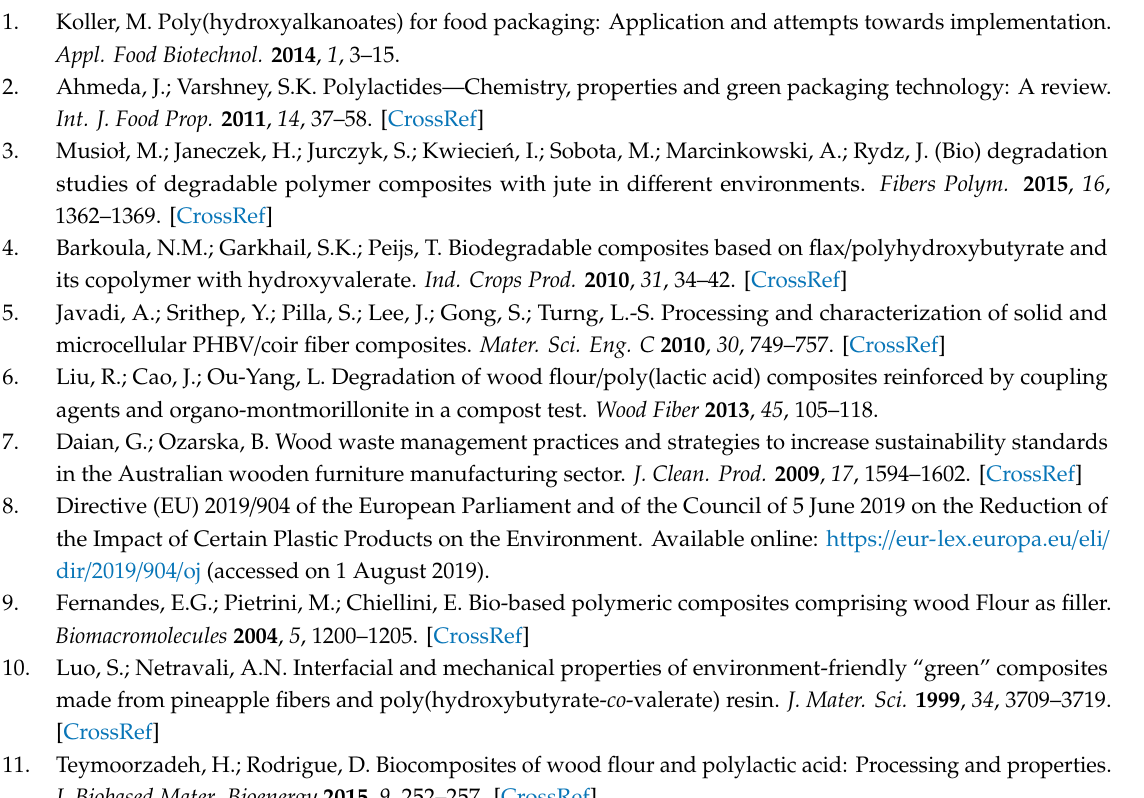
Figure S1: SEM micrographs, Figure S2: DSC